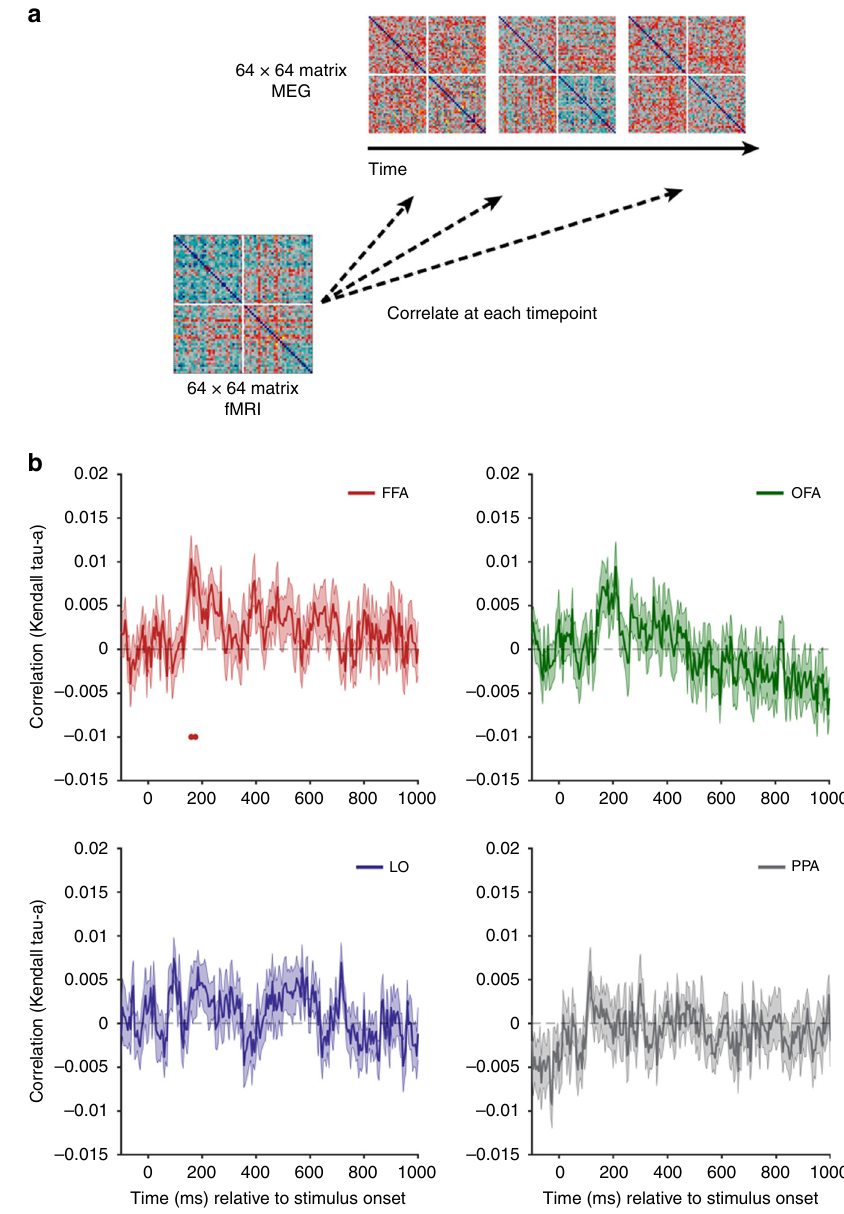
Fig. 7 fMRI-MEG fusion. a The fMRI dissimilarity matrices (1-correlation) for each of the four ROIs were correlated with the time-varying MEG dissimilarity matrix (1-correlation). Note that real human faces ( n = 32) were removed from this analysis so the matrices are 64 × 64. b Results of fMRI-MEG fusion. The mean correlation between each of the RDMs for the four ROIs with the time-varying MEG RDM is plotted relative to stimulus onset, averaged over N = 22 participants. Statistical signi fi cance is indicated by colored disks along the x -axis. Error is SEM. Source data are provided as a Source data fi